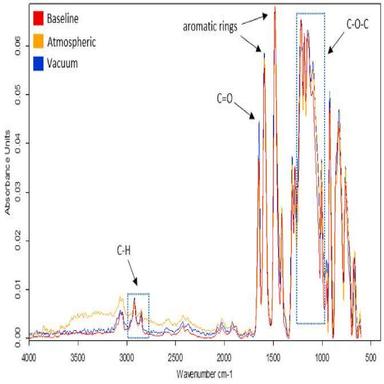
Ftir data of baseline, atmospheric, and vacuum PEEK insulations.